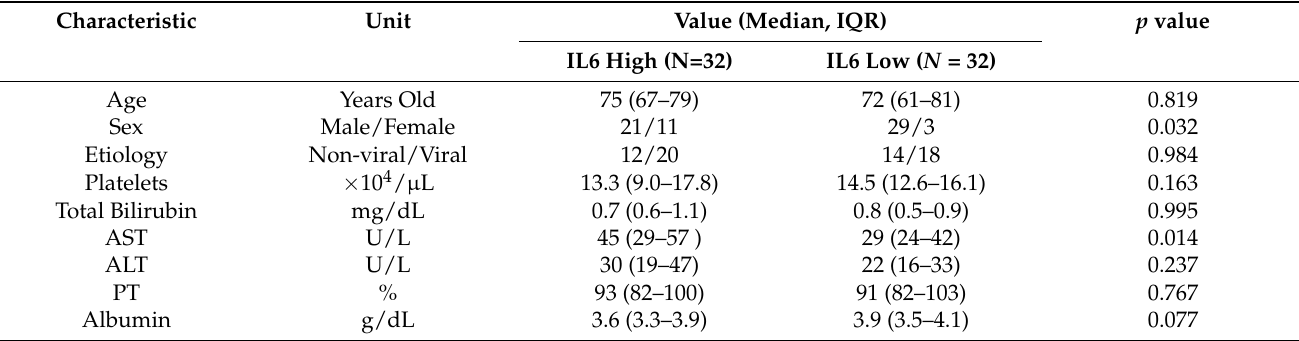
Table 3. Patients’ characteristics according to the plasma IL-6 levels.